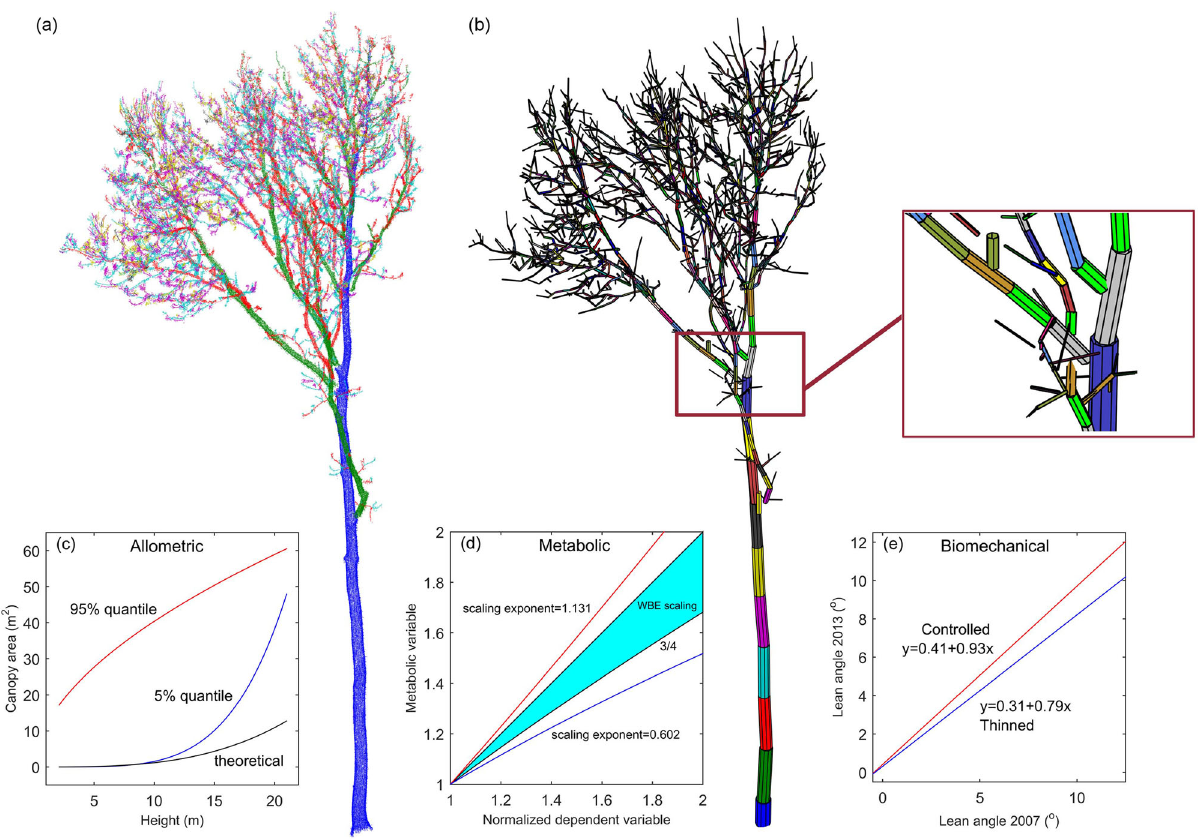
Fig. 1 The background of inspiring a rethink of the basic theories of plant forms. Illustration of ( a ) the TLS-collected point cloud and ( b ) characterized 3D structure of a woody plant, with the high potential for boosting reexaminations of the deviations from its related ( c ) allometric scaling laws, ( d ) metabolic scaling laws, and ( e ) biomechanical laws. Note that ( a ) and ( b ) were generated based on published TLS data and Quantitative Structure Model software 34 , ( c ) was generated based on the published formulas of allometric scaling 44 , ( d ) was generated by following the published formulas of metabolic scaling, i.e., scaling exponent = 1.131 for gross primary productivity 45 , scaling exponent = 0.602 for gross photosynthesis ability 46 , and scaling exponent = 3/4 ~ 1 as derived from the adapted WBE model 47 , and ( e ) was generated in accordance to the published formulas of biomechanics (in terms of lean angle) before and after tree thinning 50 . The integration of the fi ve images that re fl ect the kernel aspects of 3D reexamining the basic theories of plant forms draws the schematic framework to guide future